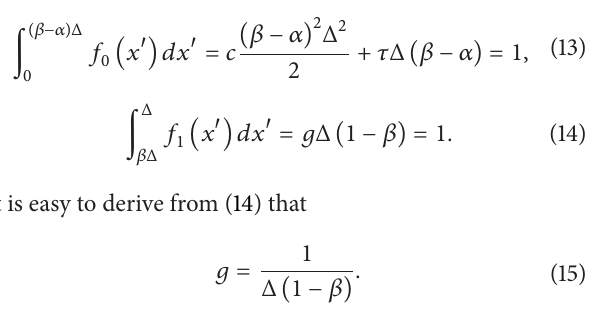
And, lastly, the condition for IDL is ((∼ 𝑏 & ∼ 𝑝) ∨ (𝑏 & ∼ 𝑞)) and it is the case when 𝑥 is not modified and therefore 𝑟